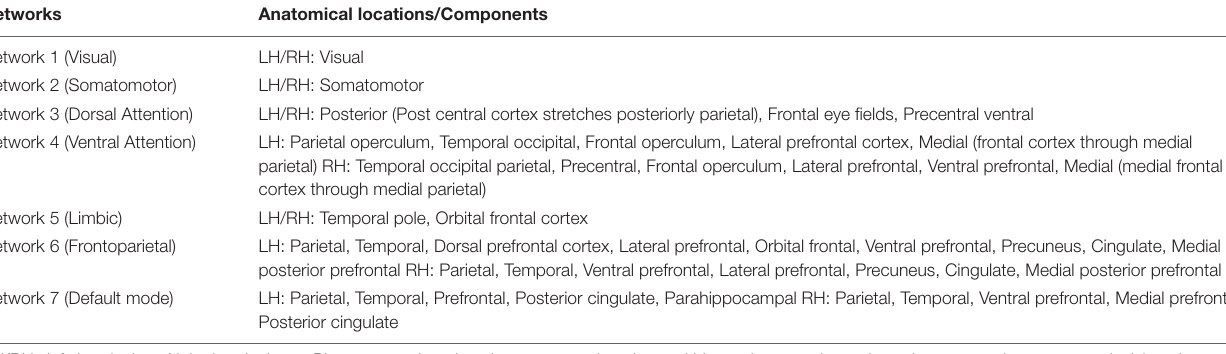
TABLE 1 | List of cortical regions/components within each functional network.